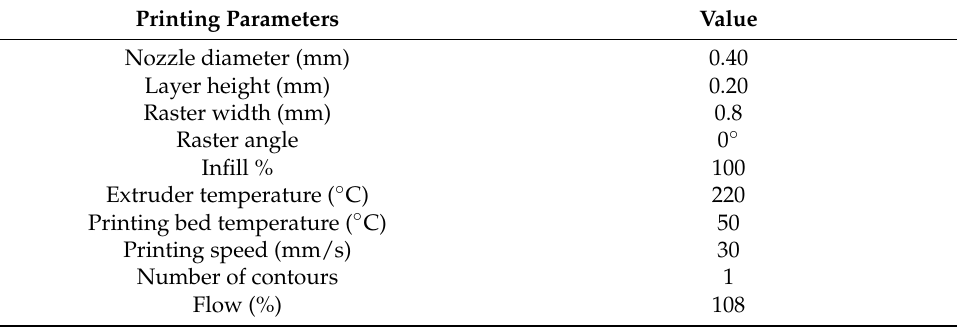
Table 3. The printing parameters used for the 3D printed